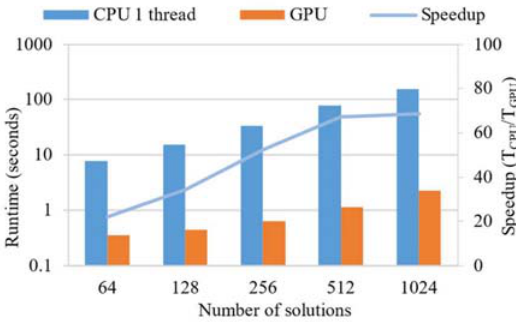
Fig. 10. Runtime and speedup for the parallel implementation on GPU using